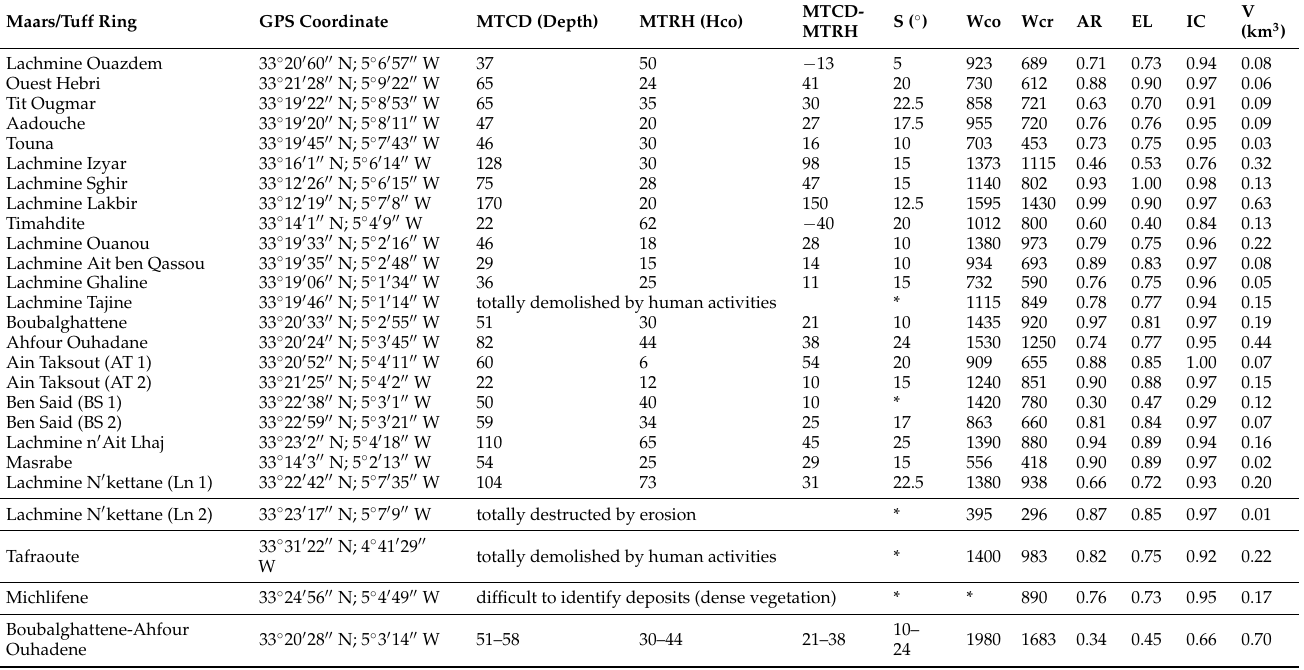
Table 2. The morphometric parameters of the maars of MAVF. With MTCD maximum theoretical crater depth; (MTRH) maximum theoretical ring height. Asterix marks no